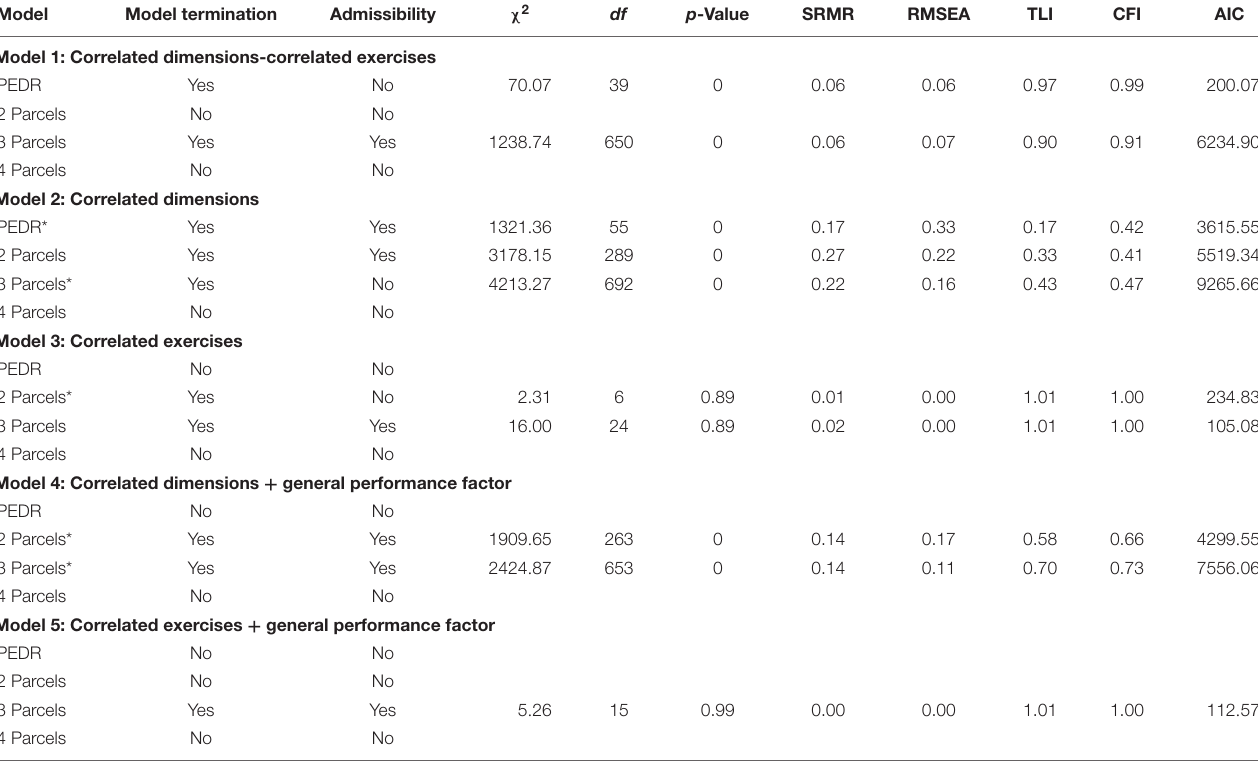
TABLE 2 | Model-data fit indices for confirmatory factor analysis models for parcels.